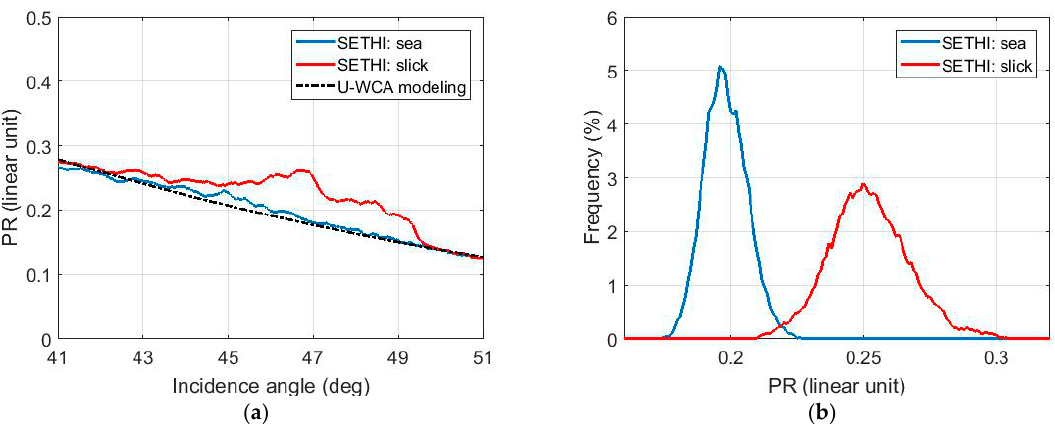
Figure 9. PR at L-band ( a ) estimated with the U-WCA scattering model (dotted black) and measured with experimental SAR data (SETHI NOFO’2015 10:02 UTC) across a range transect over a clean sea surface (blue) and a slick-covered surface (red); ( b ) Normalized histograms of experimental PR values measured at L-band (SETHI NOFO’2015 10:02 UTC) over clean sea (blue) and slick (red) surface with an incidence angle of 46°.